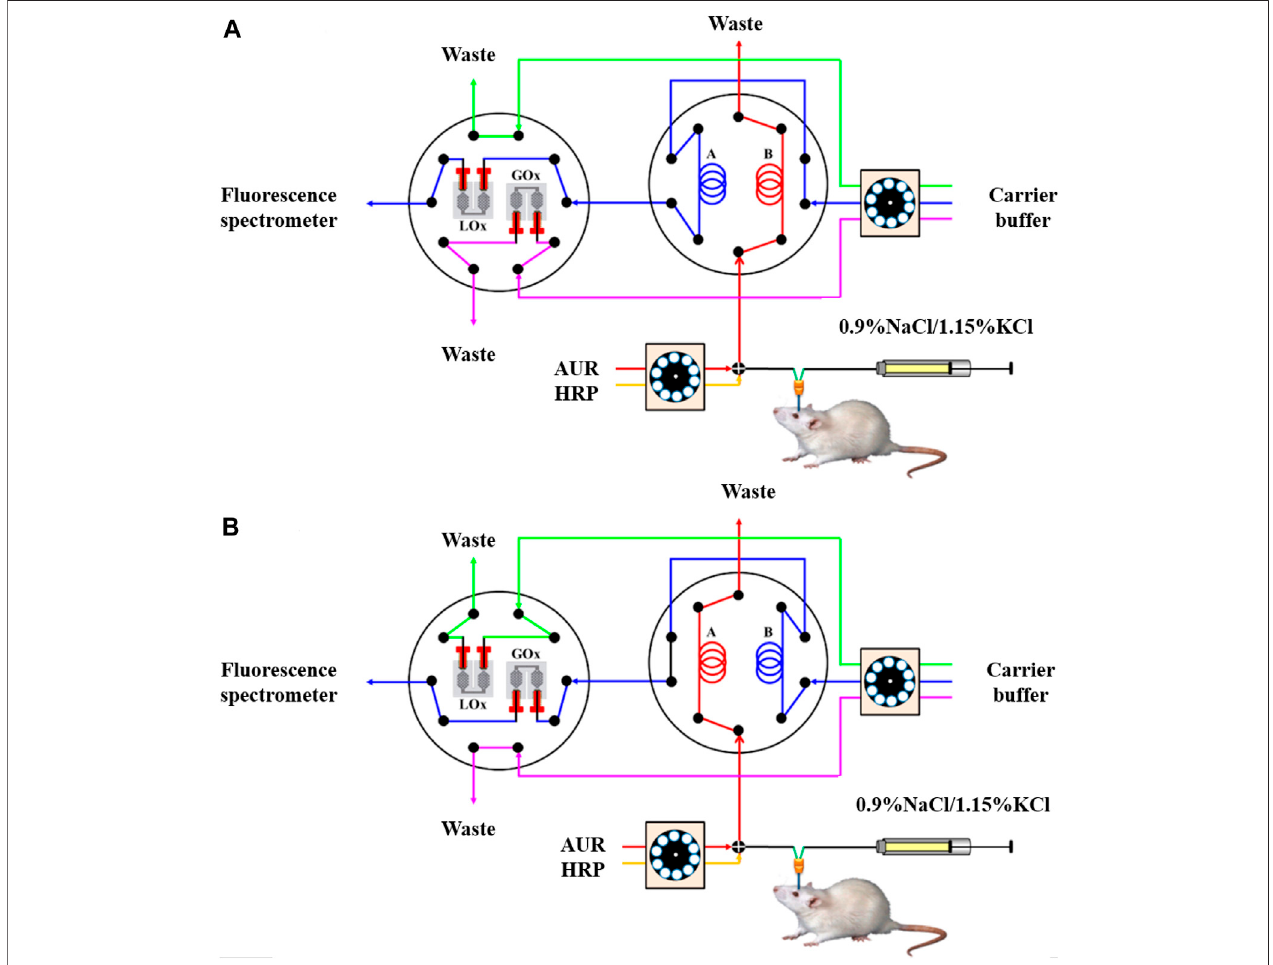
FIGURE9| Schematicrepresentationoftheproposedonlineglucose/lactatemonitoringsystem. (A) Determinationoflactate:Themicrodialysatewasmixedonline with two streams of AUR and HRP solutions and then loaded into sample loop A, while the conditioned microdialysate in sample loop B was transferred via the LOx- immobilized bioreactor to the fl uorescence spectrometer. (B) Determination of glucose: The microdialysate was conditioned online and then loaded into sample loop B, while the conditioned microdialysate in sample loop A was transferred via the GOx-immobilized bioreactor to the fl uorescence spectrometer (Reproduced with permission from Su et al.,